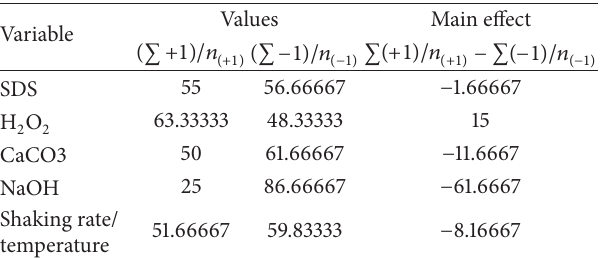
Table 2: Main effect of each variable.